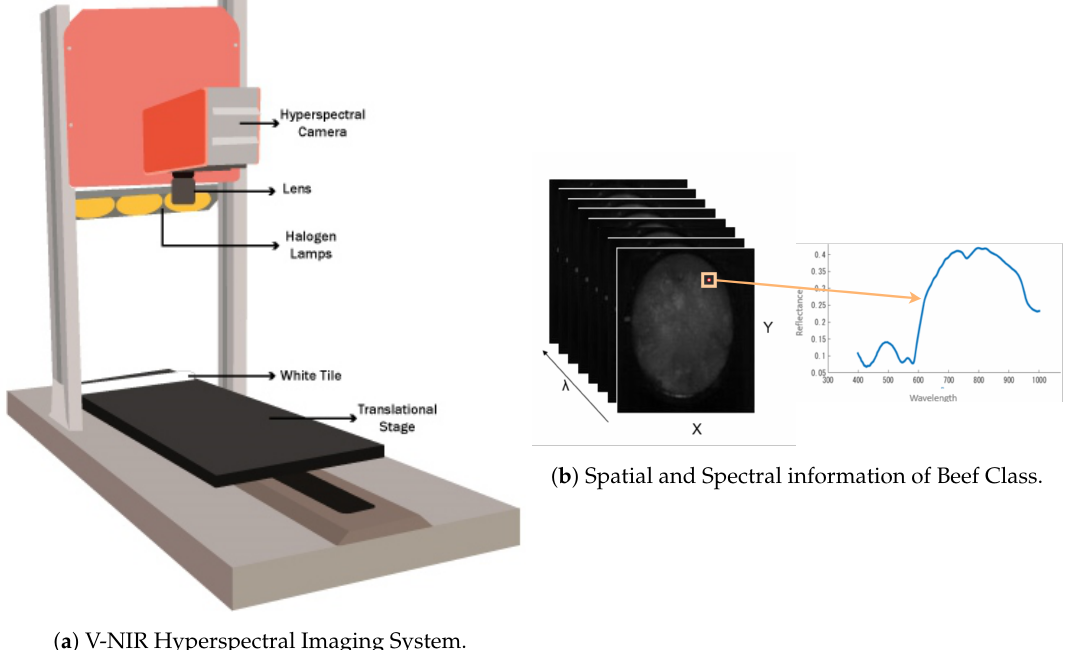
Figure 1. Laboratory protocol (Specim Fx 10) used in this study for minced meat data